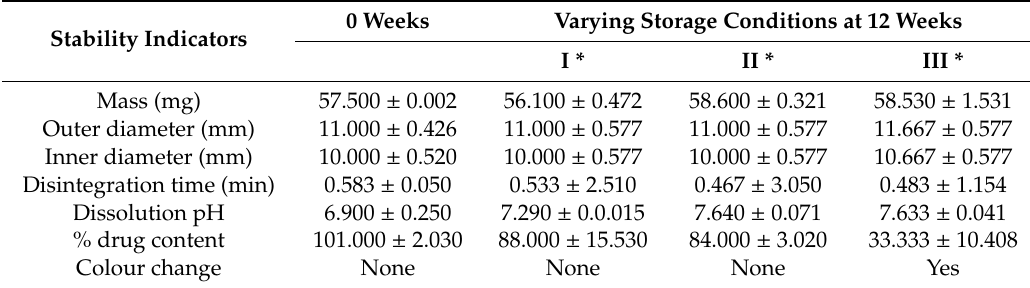
Table 3. Stability indicators recorded under di ff erent storage